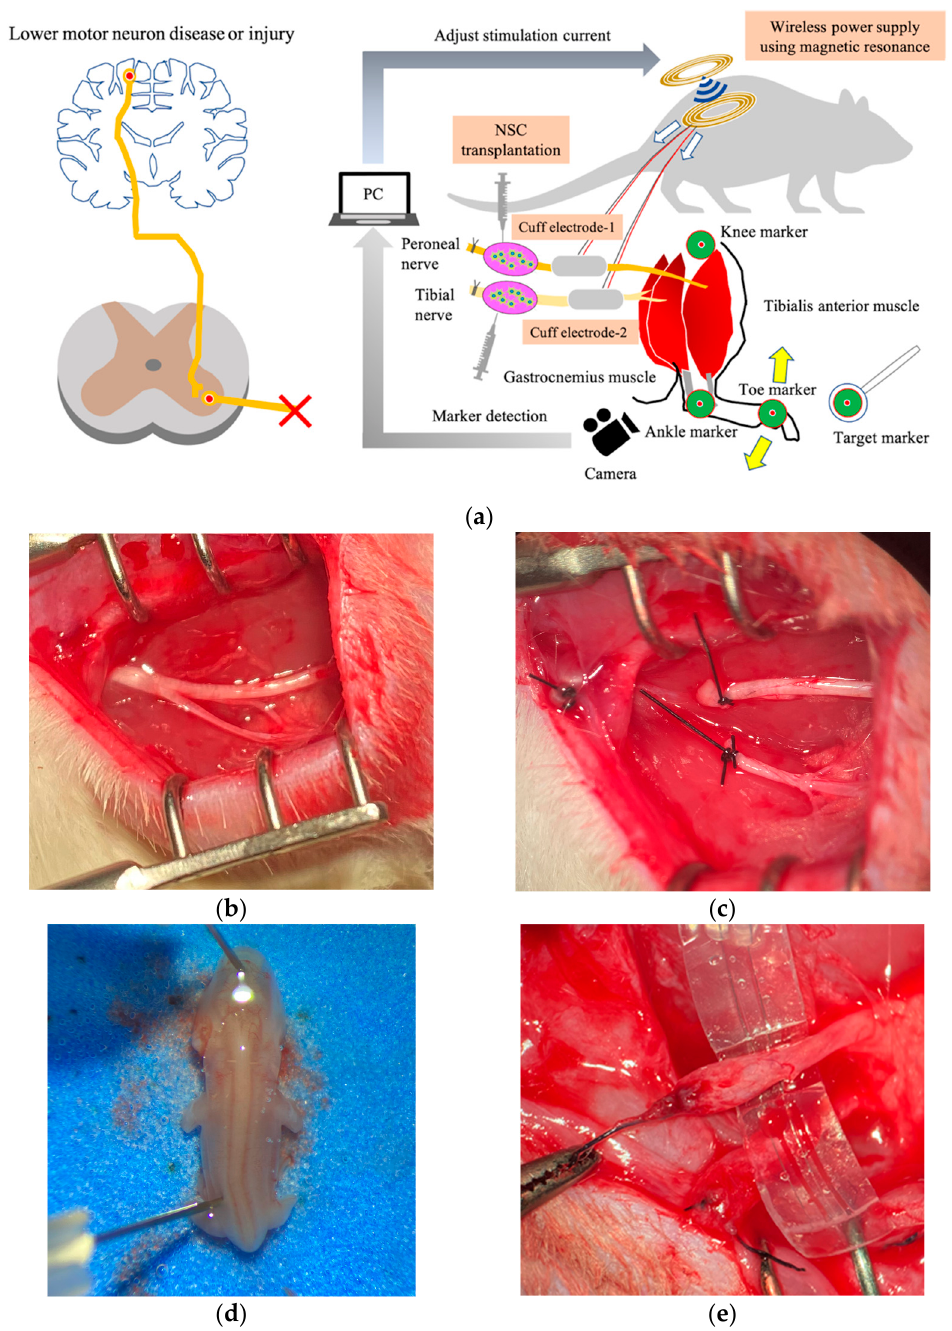
Figure 1. Novel therapeutic strategy for denervated muscles. ( a ) Scheme of denervated muscle reinnervation by stem cell transplantation and visual feedback control. ( b ) Exposure of the tibial and common peroneal nerves branching from the sciatic nerve in the thigh. ( c ) Ligation and transection of the sciatic nerve and the tibial and common peroneal nerves. ( d ) Collection of embryonic spinal cord-derived neural stem cells on E14. ( e ) Cuff electrode as interface and distal stump of nerve with ectopic ganglion four months after transplantation.